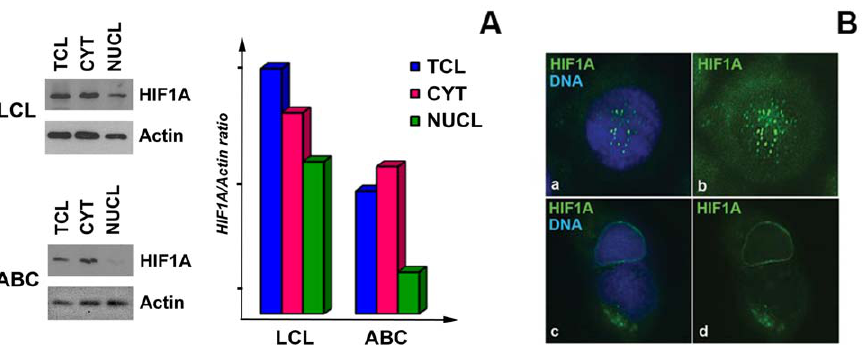
Figure 4. HIF1A is localized to the nucleus and cytoplasm in LCLs, in contrast to mitogen-activated B-cells. A – Western blotting of cellular subfractions. The membrane was probed with mouse anti-HIF1A and anti-actin antibodies (left panel). Nuclear HIF1A was detected in the lysates of LCL; however, no nuclear signal for HIF1A was detected in mitogen-activated cells. The HIF1A/actin ratio for all the probes was calculated (right panel). B – Immunostaining of LCLs and mitogen-activated cells with mouse anti-HIF1A antibody (green signal). Nuclear DNA is stained in blue. Notice the presence of nuclear HIF1A signal in LCL (panels a and b ) and its absence in the mitogen-activated cells ( c and d ).